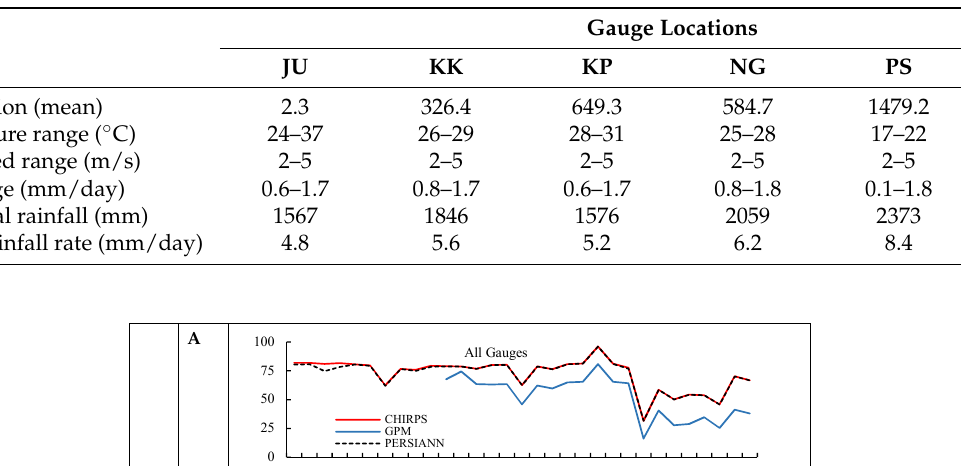
Table 2. Six gauges’ characteristics.